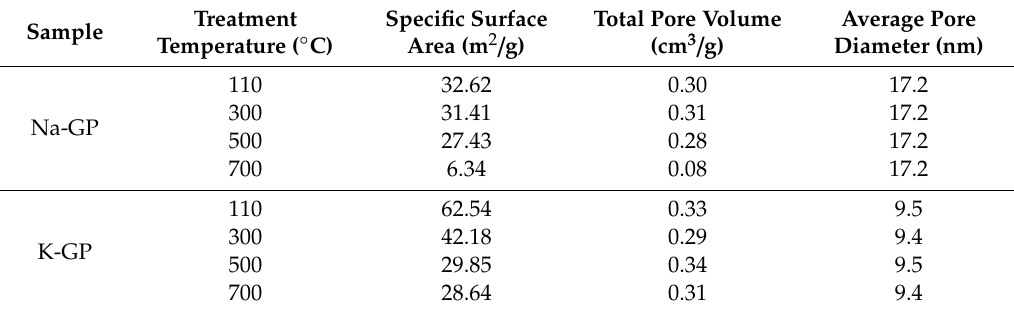
Table 1. Physical features of the geopolymer powder